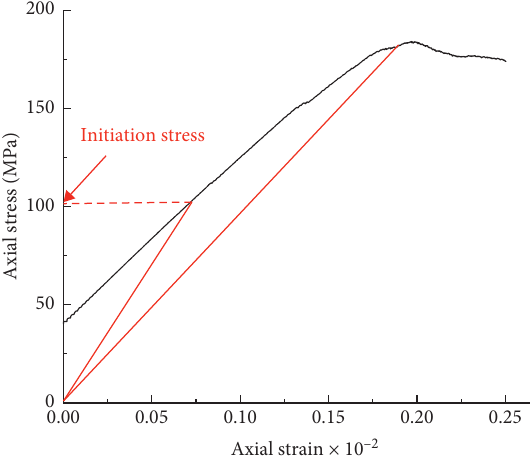
Figure 14: Predicted crack initiation